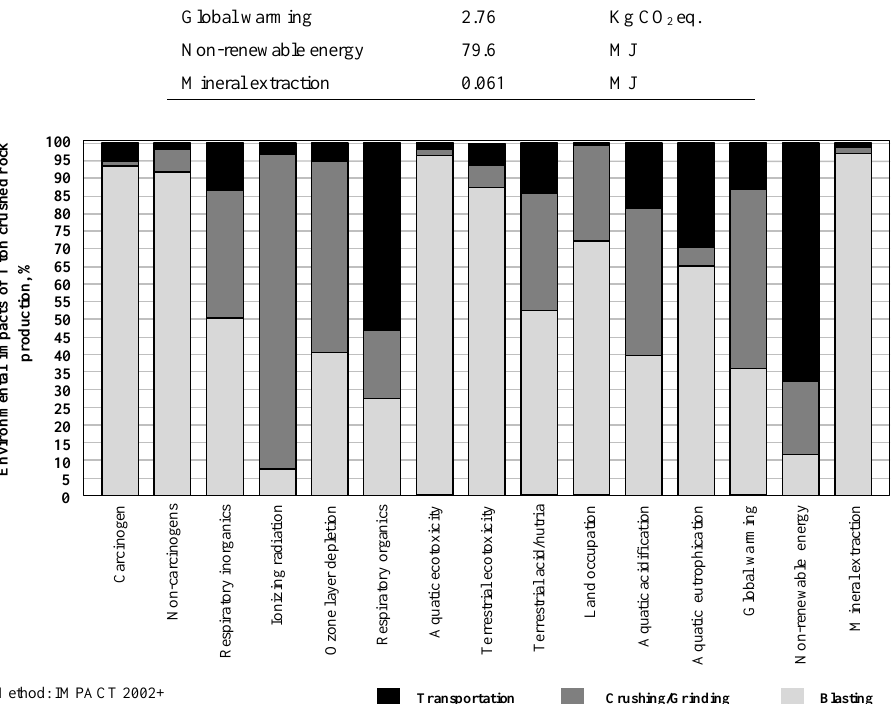
Fig. 6. Characterization of environmental impacts of 1 ton crushed limestone rock production by IMPACT 2002+,